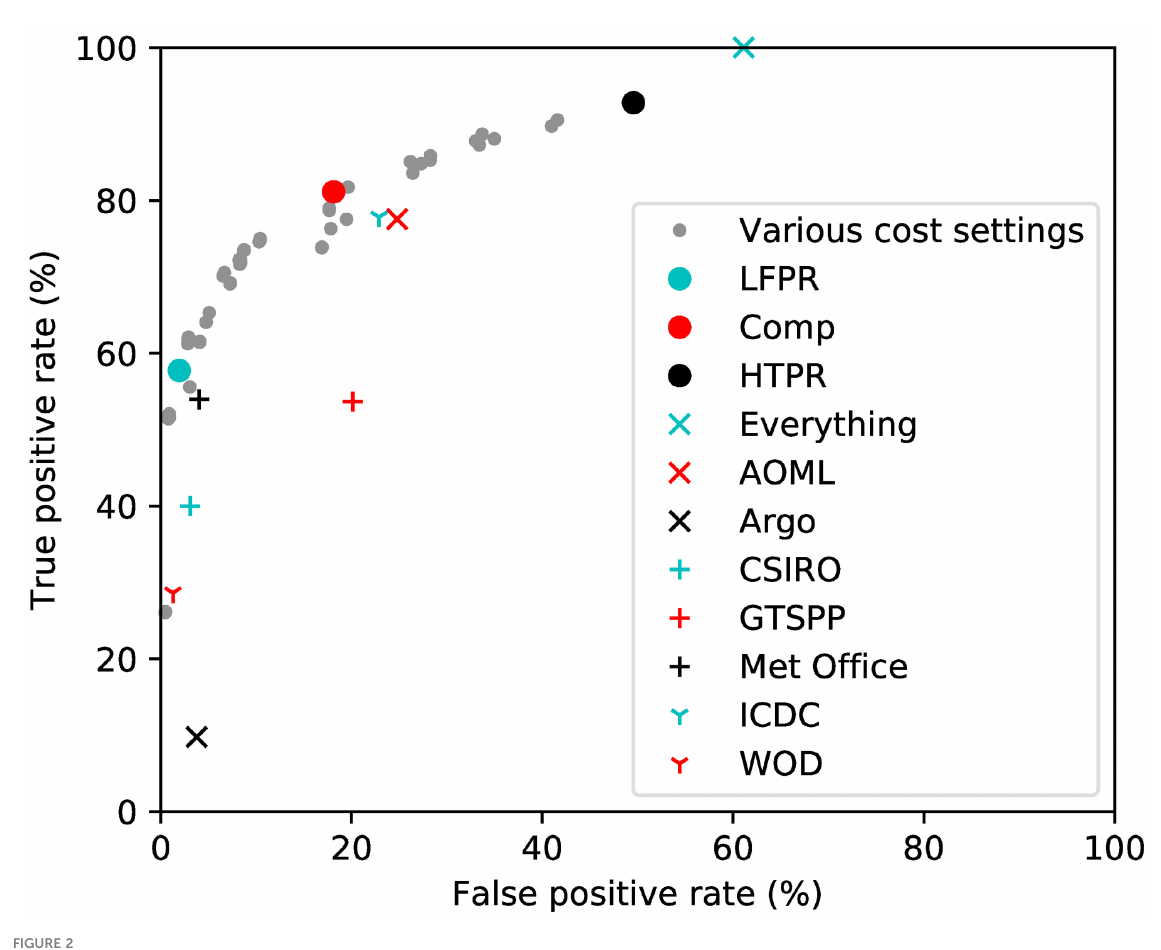
FIGURE 2 The TPR and FPR for each of the sets of QC tests, calculated from the full QuOTA